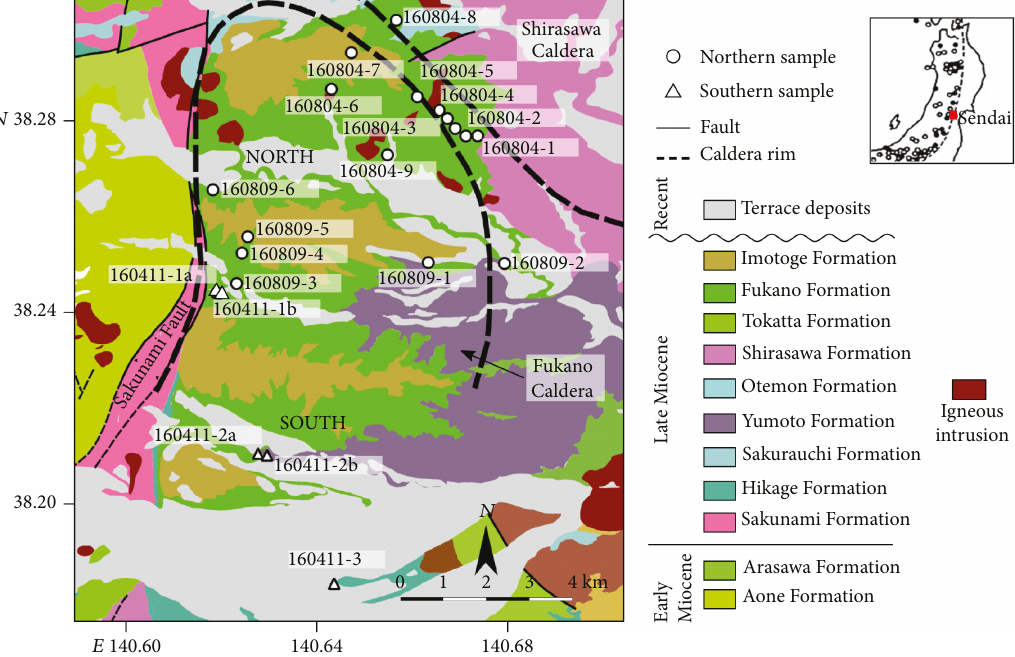
Figure 1: Geological map of Fukano Caldera (modi fi ed from Kitamura et al. [32]) showing the distribution of formations and sampling points. The red square in then inset at the top right shows the location of Fukano Caldera. The open circles and triangles show the locations of northern and southern samples, respectively. The thick dashed lines indicate the distribution of the caldera rims.